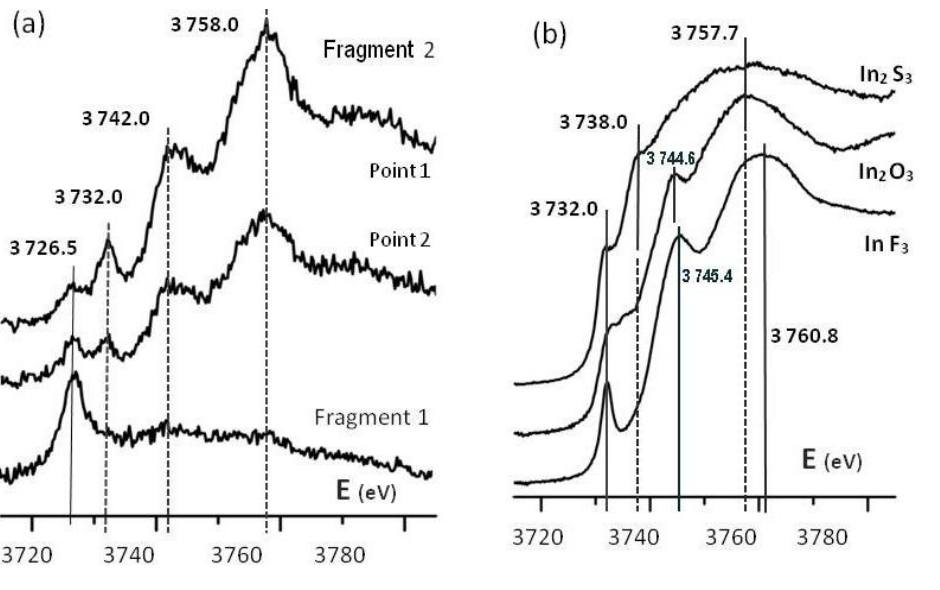
Figure 5. In L -edge XANES spectra collected from ( a ) two fragments of sample LS 3 5-180.6 (points 1 & 2 in Figure 4) and ( b ) from selected model